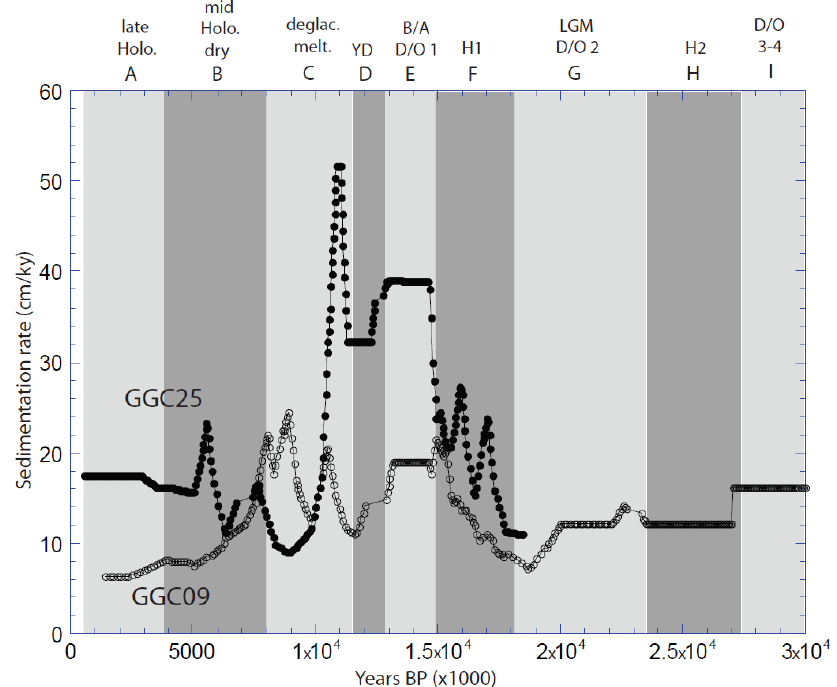
Figure 5. Sedimentation rates for GGC9 and GGC25. There is a multi-millennial-scale alternation in sedimentation rates (faster–slower) that is indicated by grey versus white zones labeled A–I. These correspond to labeled zones in Figures 6–9.